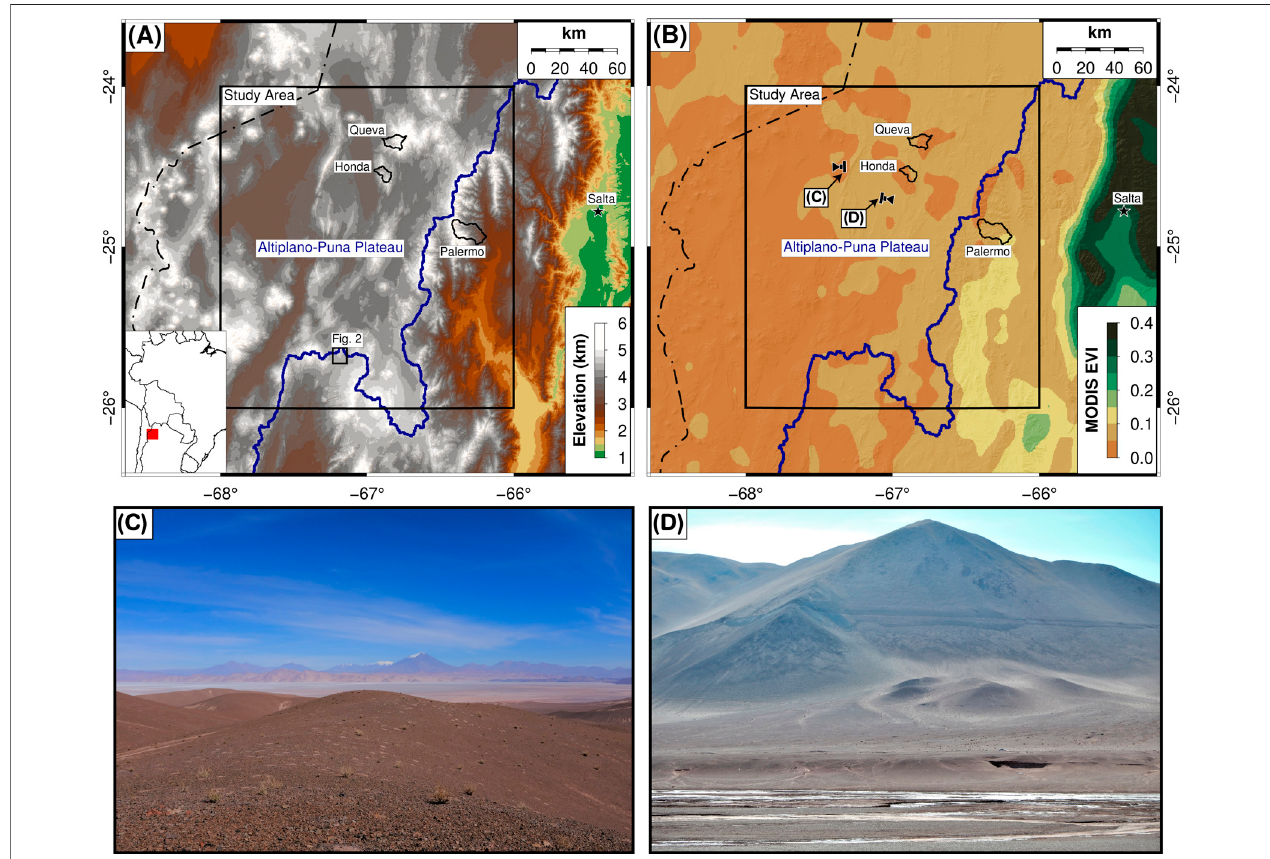
FIGURE 1 | Overview of the study area in Northwest Argentina. (A) Elevation and hillshade derived from Copernicus DEM. (B) Vegetation derived from MODIS product 13C1 enhanced vegetation index 14-years average (MODIS EVI; Huete et al., 1994). No vegetation is typically de fi ned by EVI values < 0.3, and the maximum valueinthestudyareais < 0.2.Drainageboundaryoftheinternally drainedAltiplano-PunaPlateau isshown indark blue, withcatchmentsselectedforslope andchannel analysis shown in black. (C) and (D) are the photographs identi fi ed in (B) , which demonstrate the smooth topography and nearly vegetation-free characteristics of the study area, with a combination of steep volcanoes, mountain ranges, fl at salars, and local bedrock outcrops.